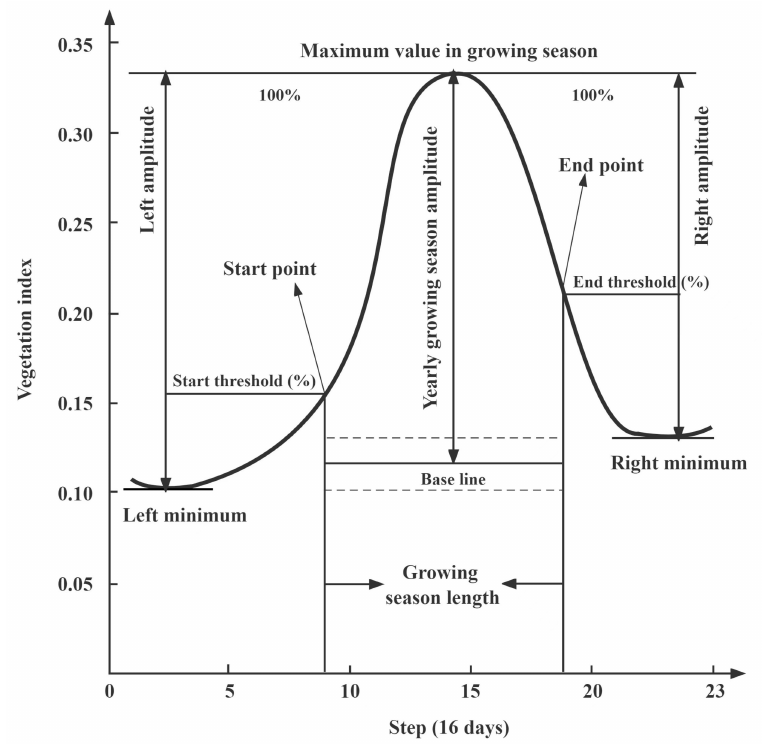
Figure 2. The principle of dynamic threshold method for extracting phenology based on vegetation index time-series